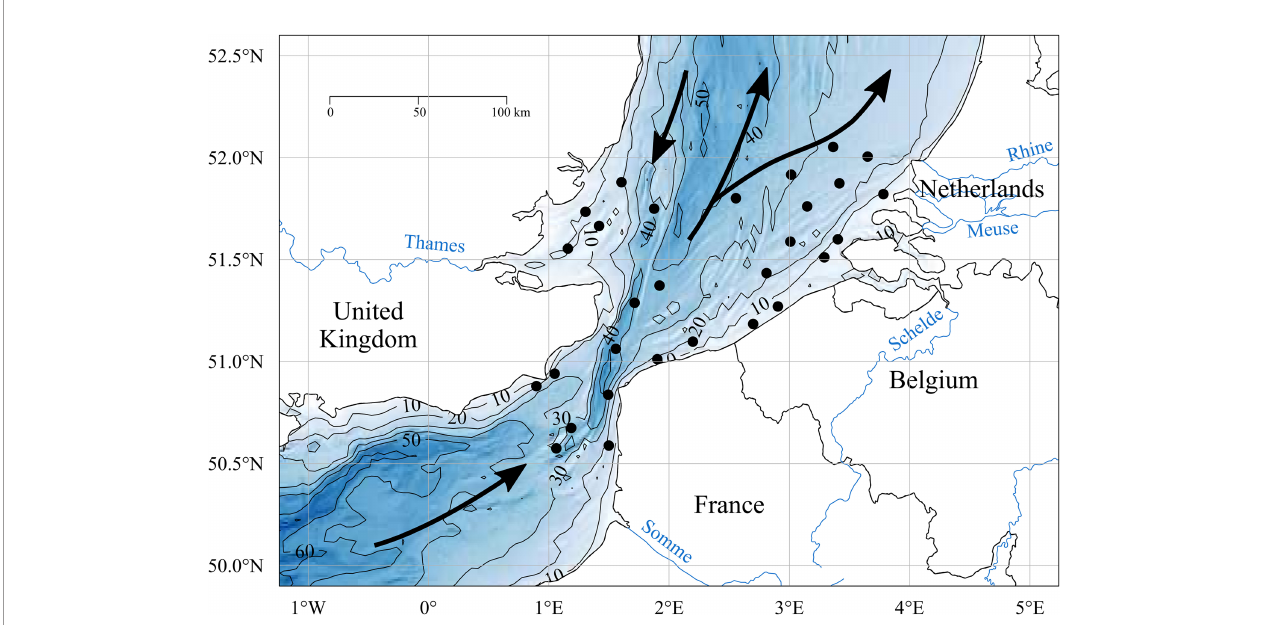
FIGURE 1 | (IN COLOUR). Map of the study area with the black dots representing the sampling stations. The contour lines indicate the depth in meters, associated with gradual colours. The main residual currents of the study zone are indicated with the black arrows, and the main freshwater outputs by the represented rivers (blue